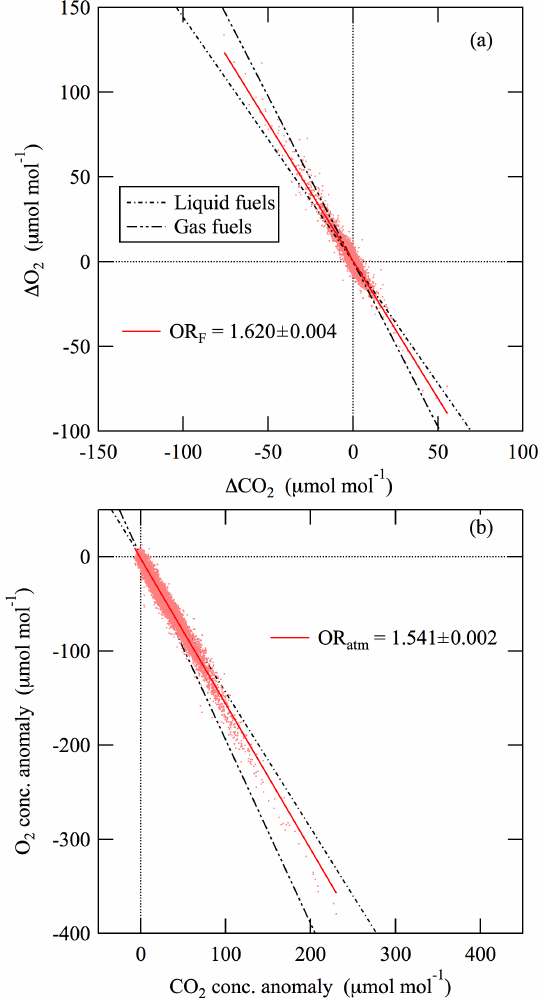
Figure 5. (a) Relationship between the (cid:49) O 2 and (cid:49) CO 2 shown in Fig. 2. The average OR F (see text) for the observation period, de- rived from the Deming regression fitted to the data, is also shown. (b) Same as in (a) but for the deviations of O 2 and CO 2 concentra- tions from their baseline variations shown in Fig. 3 and the average OR atm (see text). OR values expected from the consumptions of gas and liquid fuels are also